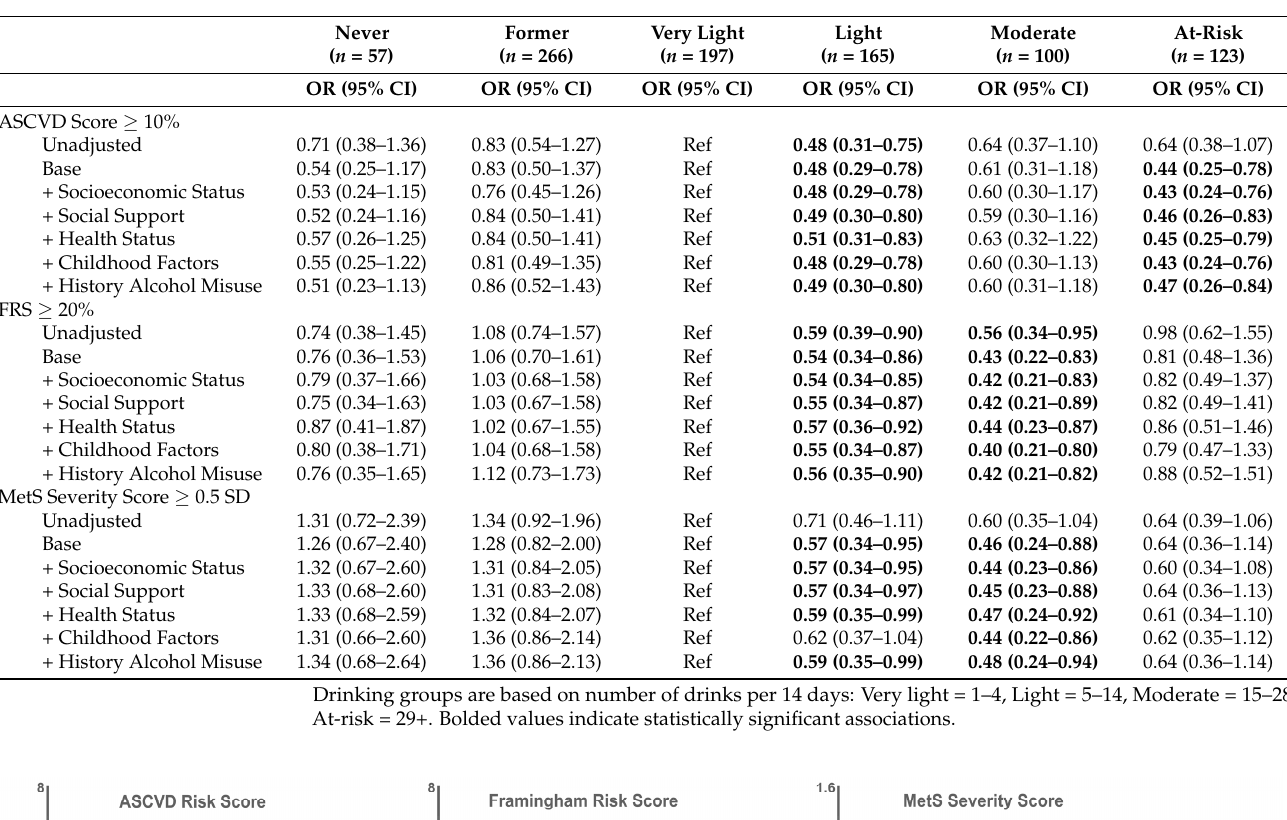
Table 5. Unadjusted and adjusted odds of exceeding specific risk thresholds for each CVD risk score by drinking group. Additional individual models add adjustment for variables grouped by potential explanatory hypotheses.